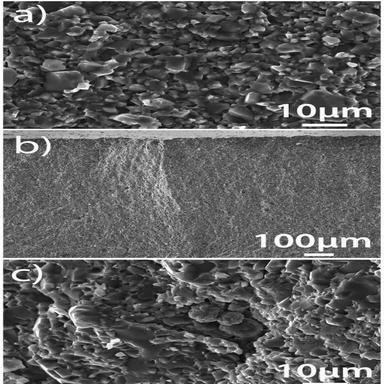
Characteristic features found in the fracture surfaces of specimens of both thicknesses of the alumina material. SEM micrographs of a Au-coated surfaces. a) Microstructure of the material. b) One of the three parts of a specimen of 0.5 mm, divided in three parts, with average value of fracture strength, 316 MPa. The tensile zone is in the upper part of the micrograph. c) Critical defects. Differential sintered zone in the vertex tensile zone. Detail of Fig. 8a).